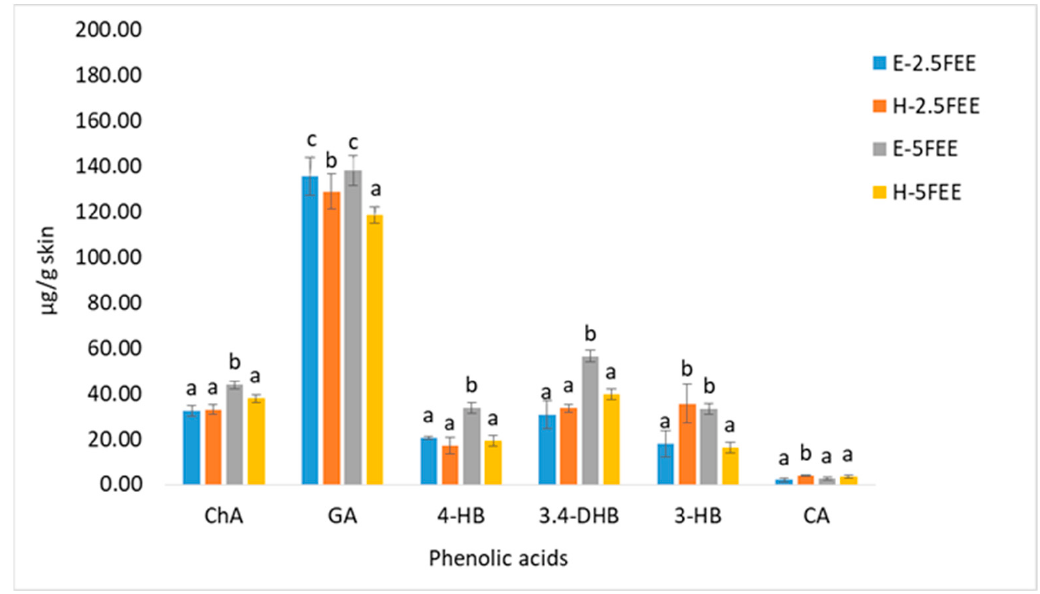
Figure 9. The content of phenolic acids in the solution obtained after the skin extraction collected after 24-h penetration. Vertical lines represent the standard deviation, n = 3. Different letters—values are significantly different, α < 0.05.